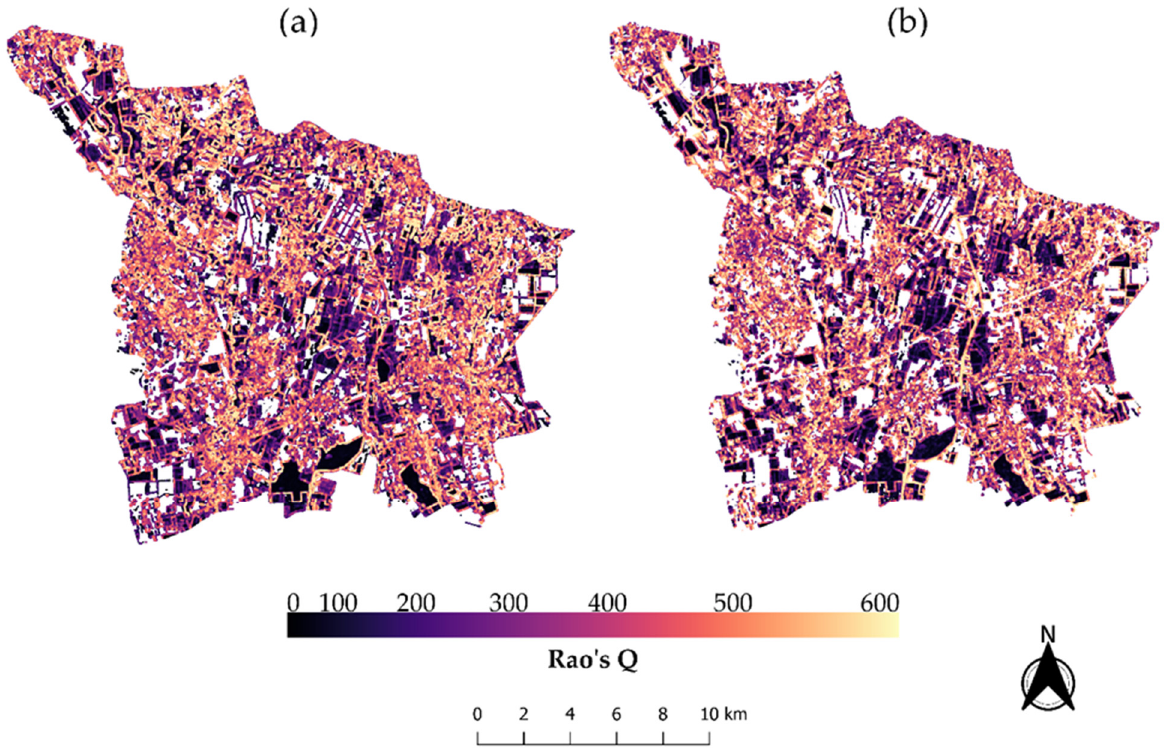
Figure 3. Rao’s Q index, calculated from the NDVI time series covering the year 2019 (Q NDVI ) with the weight for the distance matrix set to infinite, for the study area ( a ). Rao’s Q index, calculated from the 10 bands of the Sentinel 2 image of 3 June 2019 (Q multi ) with the weight for the distance matrix set to infinite, for the study area ( b ).